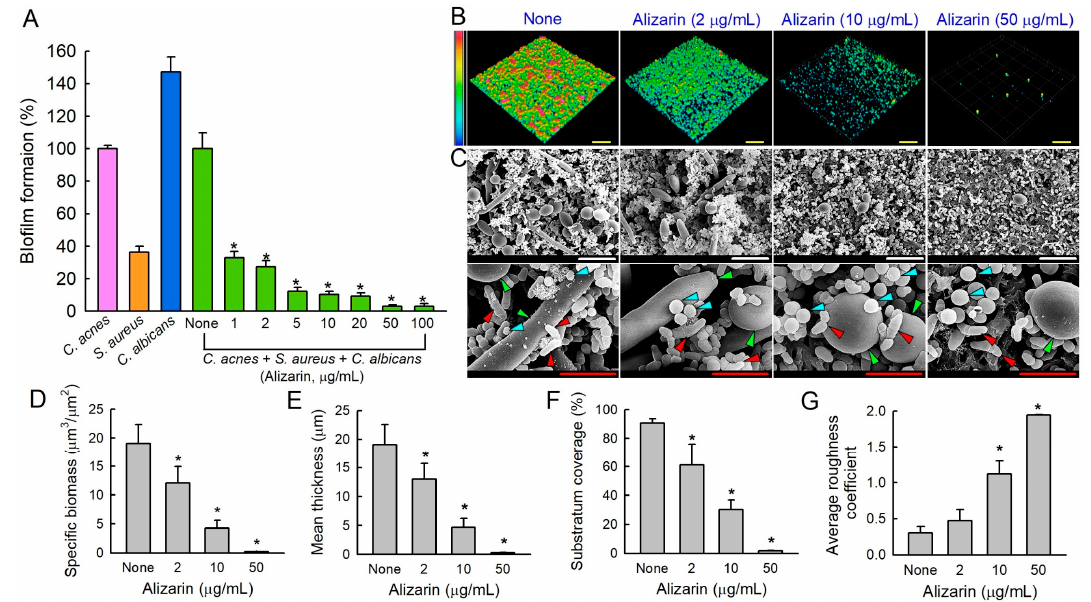
Figure 3. Alizarin inhibited multispecies biofilms. The antibiofilm effects of alizarin on C. acnes/S. aureus/C. albicans biofilms ( A ) after 7-day culture under anaerobic conditions. * p < 0.05 vs. non- treated controls (None). CLSM images of biofilm inhibition ( B ) and COMSTAT analysis of CLSM images ( D – G ). Yellow scale bars represent 100 µm. SEM images of polymicrobial biofilms devel- oped in the presence or absence of alizarin ( C ). White and red scale bars indicate 10 and 3 µm, respectively. Red, blue, and green triangles represent C. acnes , S. aureus , and C. albicans , respectively. None; non-treated control.